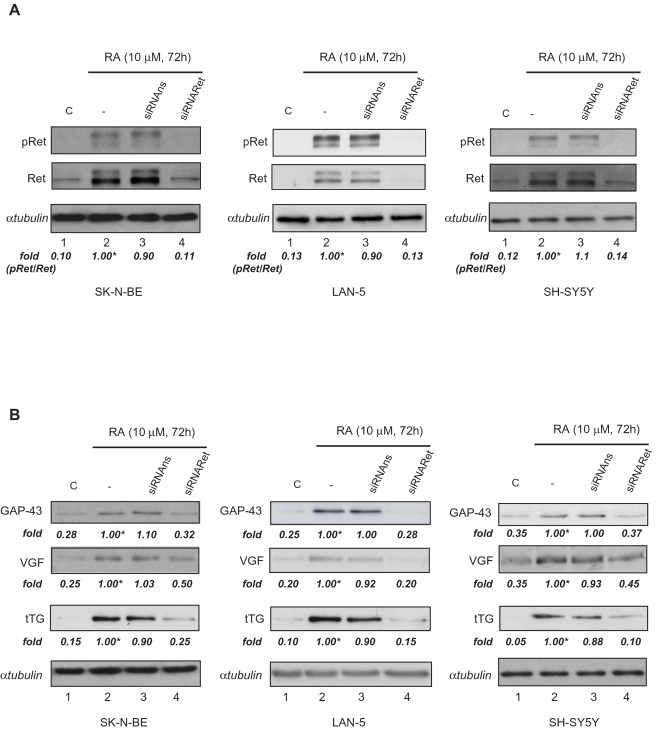
Ret activity is involved in RA-induced NB cell differentiation.(A) and (B) SK-N-BE (left panels), LAN-5 (middle panels) and SH-SY5Y (right panels) cells were either left untreated (lane 1) or RA-treated (lane 2); RA-treated cells were transfected with Ret specific siRNA (siRNARet in lane 4) or a non-silencing control siRNA (siRNAns in lane 3). C, mock-treated cells. (A) Cell lysates were immunoblotted with anti-pRet or anti-Ret antibodies. To confirm equal loading the filters were stripped and reprobed with anti-αtubulin? antibodies, as indicated. Quantitations are done on the sum of the two Ret-specific enhanced chemiluminescence bands of 170 and 150 kDa corresponding to different glycosylation states of Ret. Intensity of bands have been calculated using the NIH Image Program on at least two different expositions to assure the linearity of each acquisition. Fold values are expressed relative to the reference points, arbitrarily set to 1 (labelled with asterisk). (B) To follow biochemical cell differentiation lysates were immunoblotted with anti-VGF, anti-GAP-43 or anti-tTG antibodies. The filters were blotted with anti-αtubulin? antibodies to normalize the loaded proteins, as indicated. Quantitation and relative abundances are expressed relative to controls, arbitrarily set to 1 (see A). Blots shown in (A) and (B) are representative of at least four independent experiments.